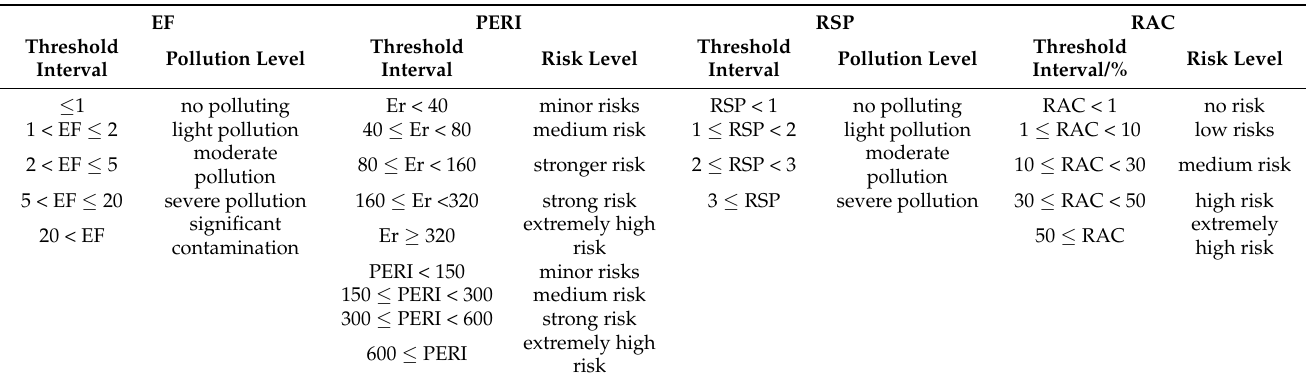
Table 1. Enrichment factor, potential ecological risk assessment index, risk assessment code, and ratio of the secondary phase and primary phase grading